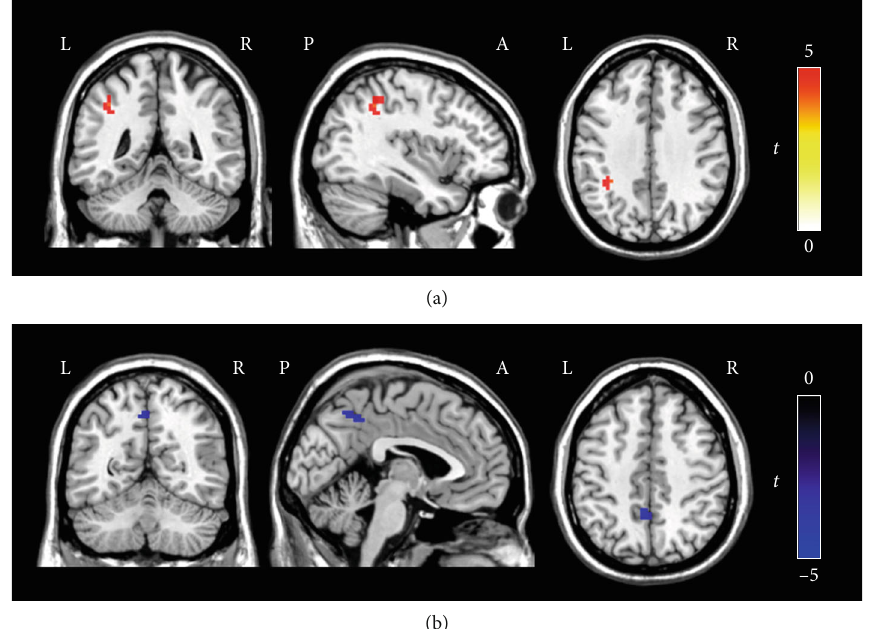
Figure 3: Regions showing di ff erent DC in the DAN between the tinnitus patients and healthy controls (voxelwise P < 0 : 001 , FWE- corrected clusterwise P < 0 : 05 ). (a) The tinnitus patients showed increased DC in the left inferior parietal gyrus in the DAN compared to the healthy controls. (b) The tinnitus patients showed decreased DC in the left precuneus in the DAN compared to the healthy controls. The color bar indicates the t value of independent two-sample t -tests between the groups. Red represents increased DC in the tinnitus patients compared with the healthy controls, while blue shows decreased DC. Acronyms: DAN: dorsal attention network; DC: degree centrality; FWE: familywise error; L: left; R: right; A: anterior; P: